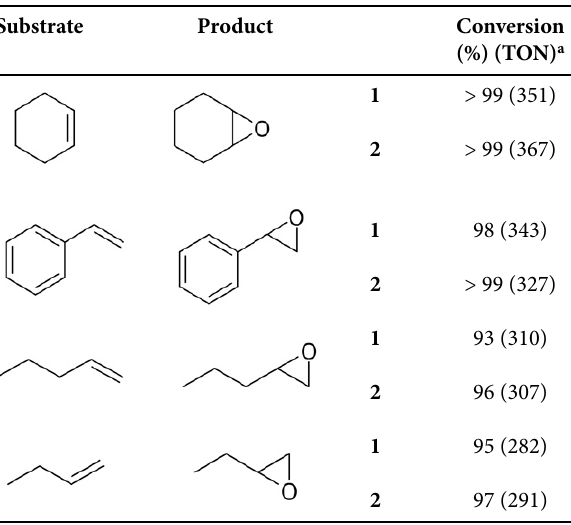
Table 4. The catalytic oxidation results Substrate Product